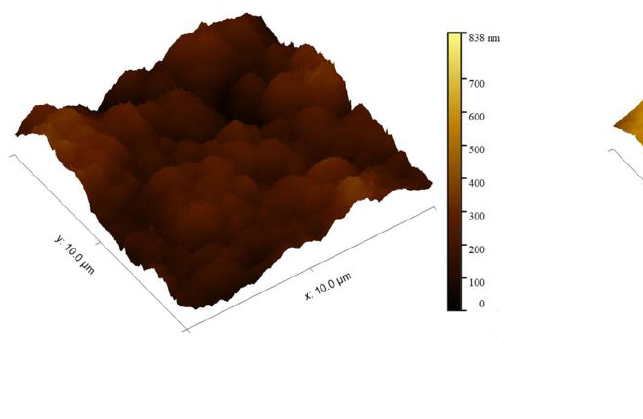
Figure 13. The 10 × 10 µm 2 3D atomic force microscopy (AFM) topography images of ( a ) NiSn-P3.3- alloy and ( b ) NiSn-rGO-P3.3.